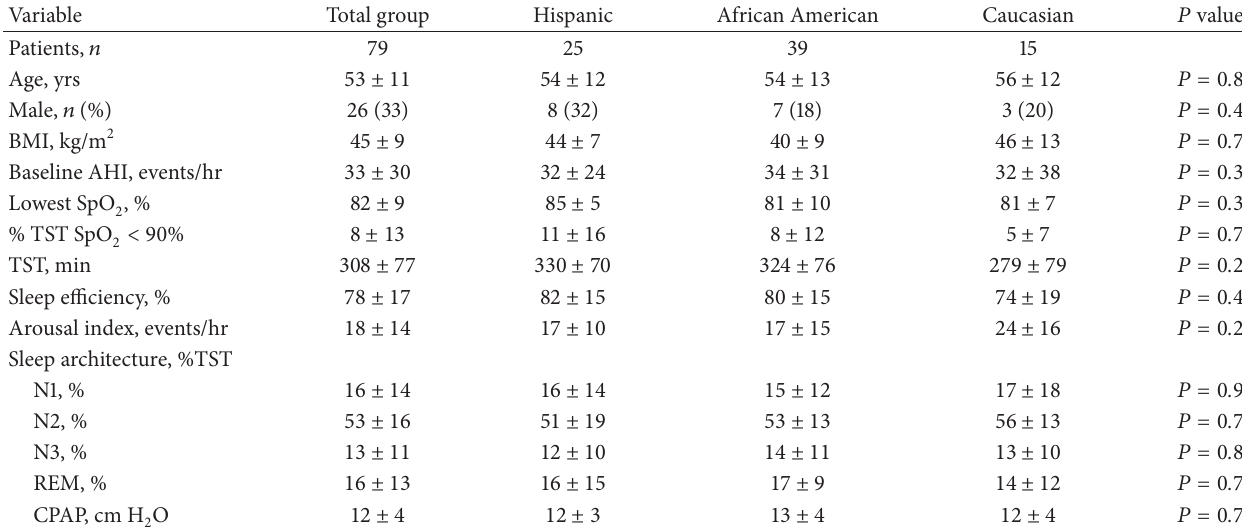
Table 1: Baseline characteristics ∗ .